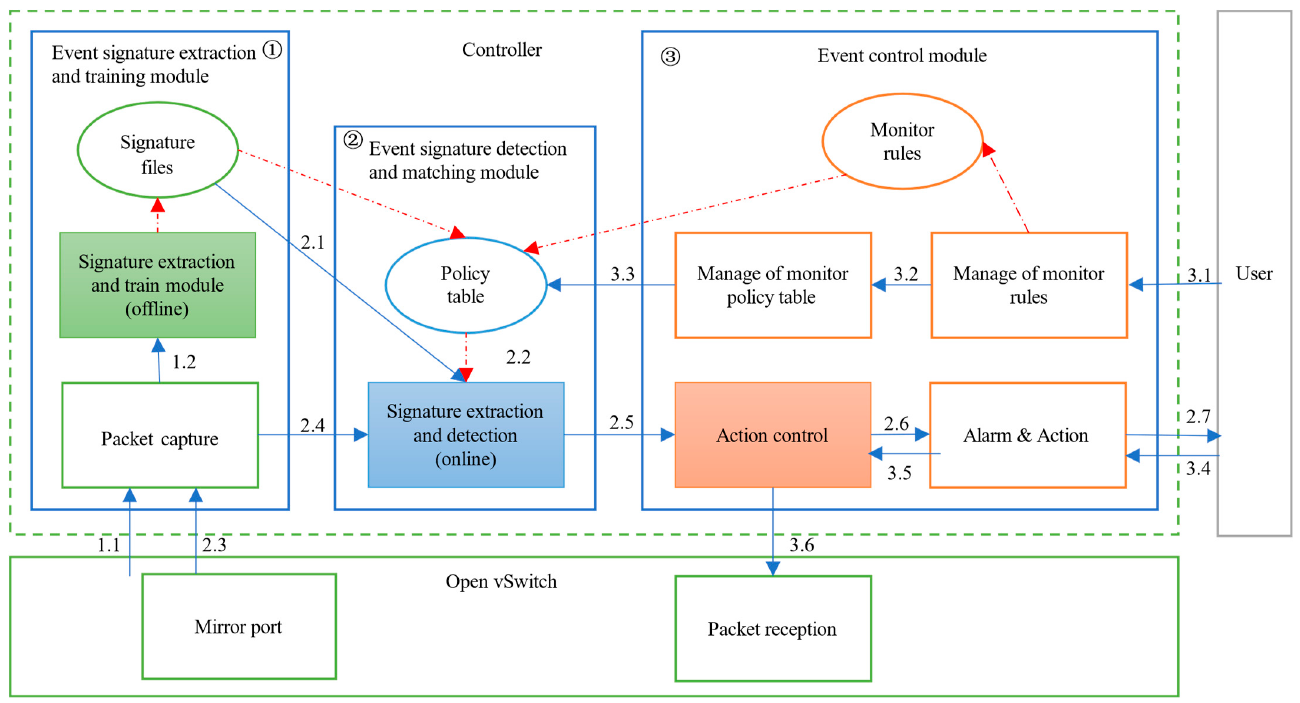
Figure 6. HomeMonitor